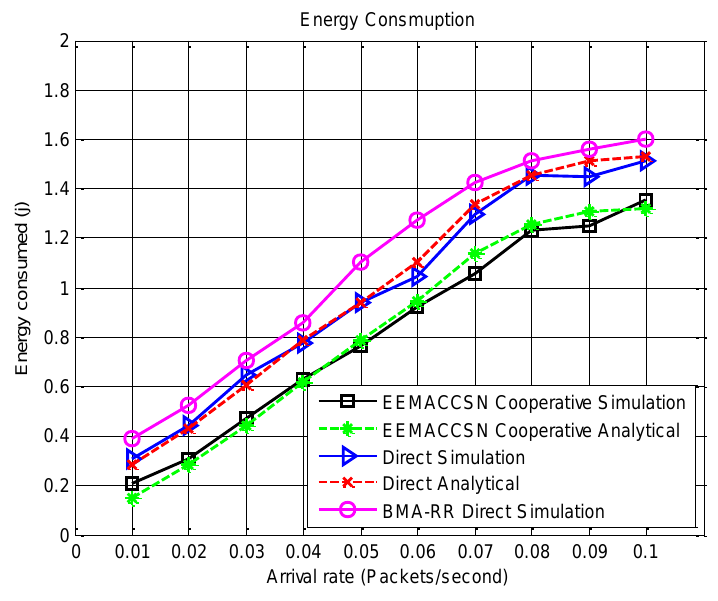
Figure 10. Total energy consumption per node vs. arrival